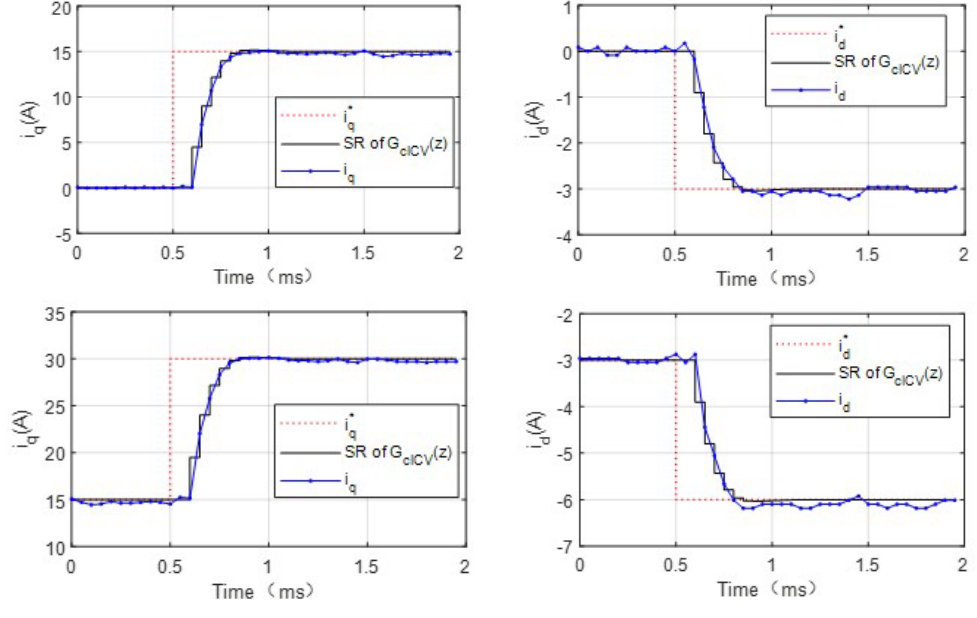
Figure 16. Experiment result of PI controller based on DIMC ( α = 6473 rad/s, f s = 10 kHz) of the high-speed saturated machine ( f out = 833 Hz).